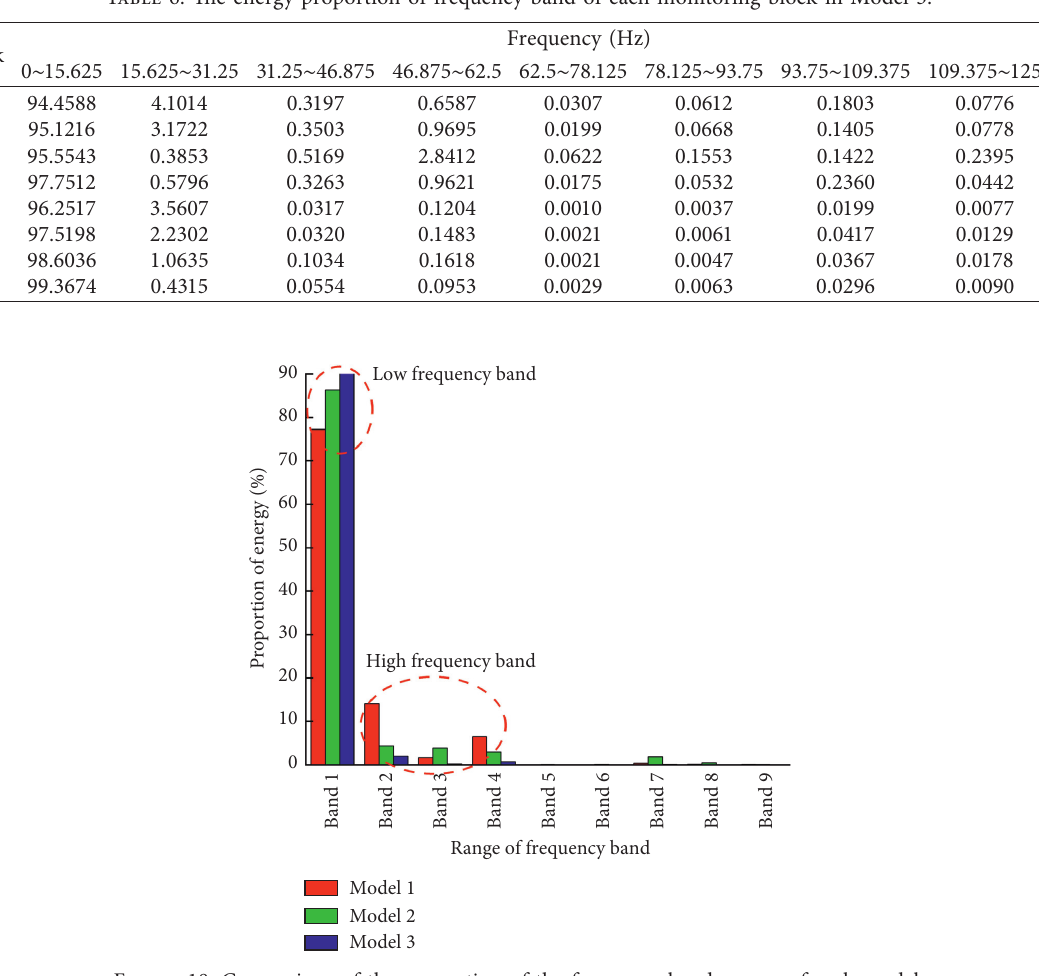
Table 6: The energy proportion of frequency band of each monitoring block in Model 3.